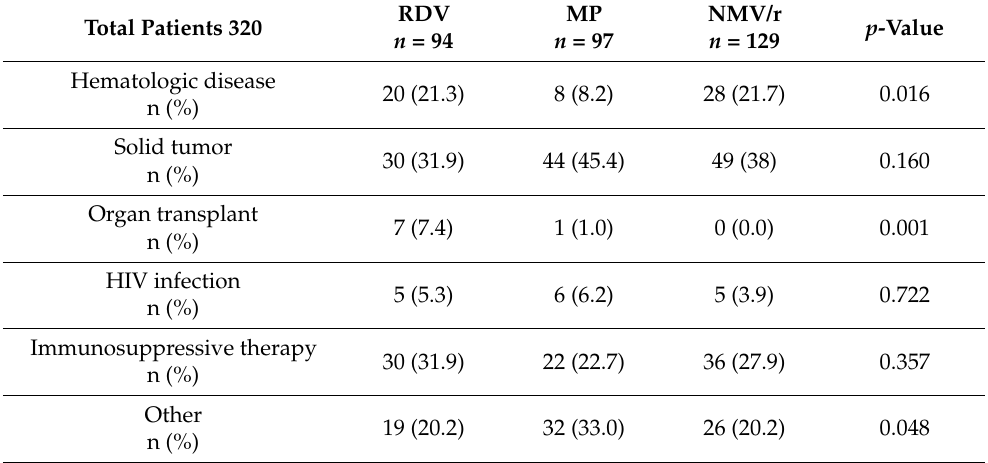
Table 2. Univariable analysis of immunodeficient patients’ subgroup. Others: diabetes mellitus, cardiovascular disease, Down’s syndrome and other rare diseases (Proteus syndrome, Shwachman– Diamond